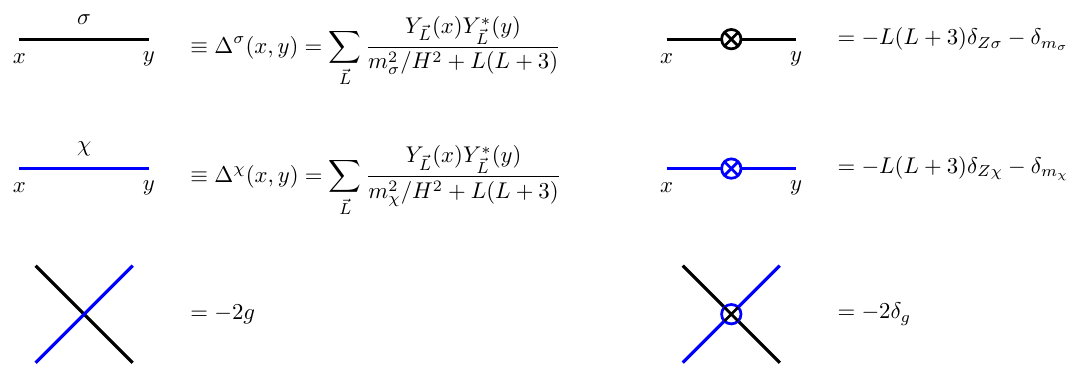
Figure 1 . Feynman rules from the Lagrangian in eq.